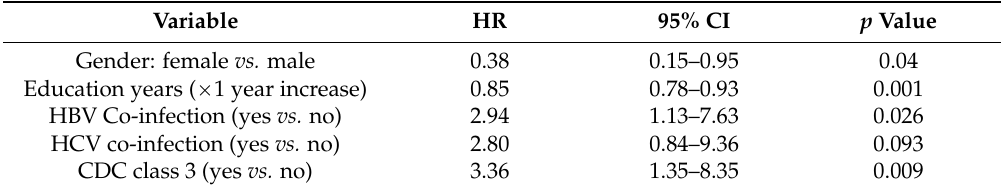
Table 2. Multivariable logistic regression of baseline risk factors for HIV-Associated Neurocognitive Disorders (HAND) presentation (stepwise backward